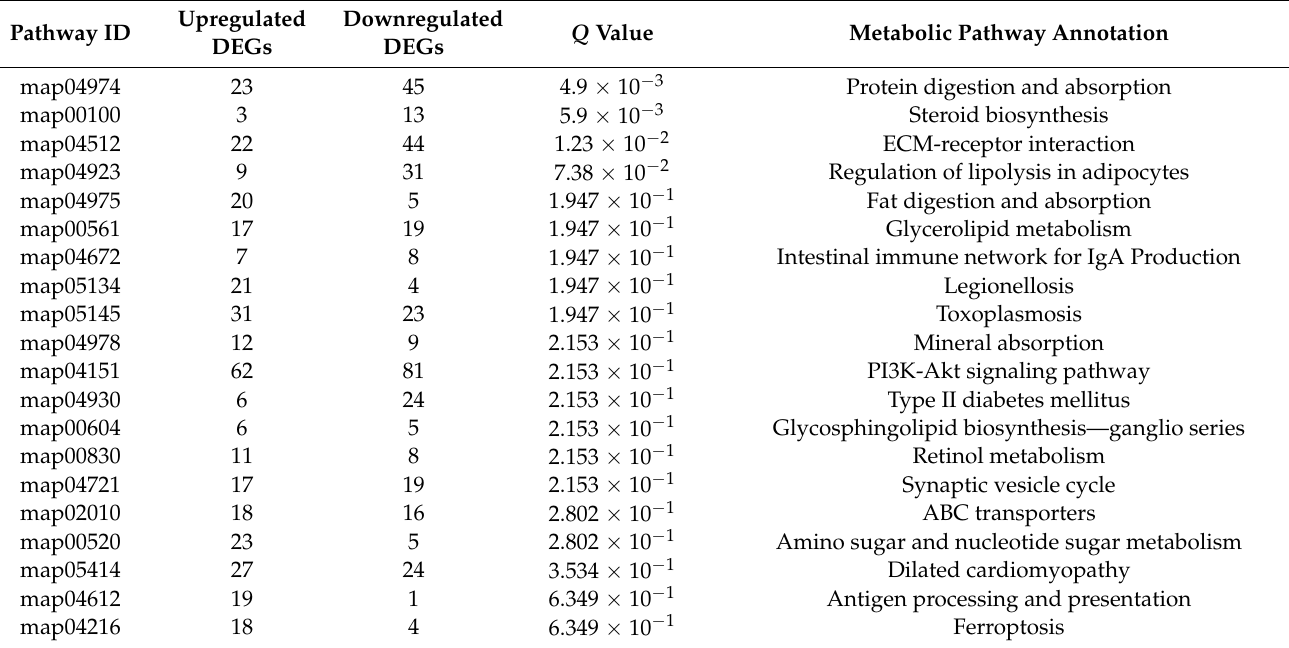
Table 2. Top 20 KEGG metabolic pathways of HM-group vs. differential control genes.